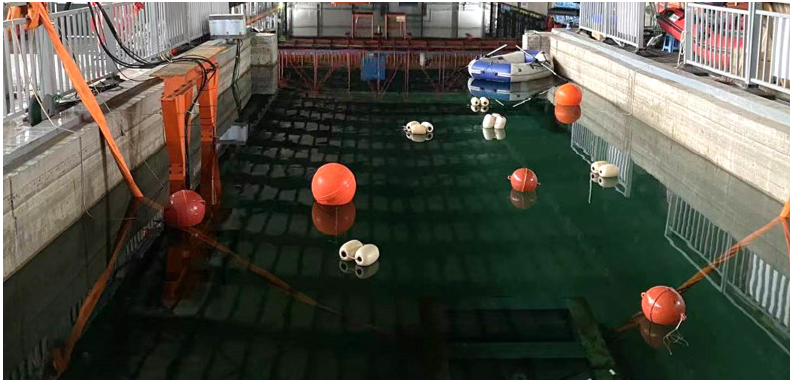
Figure 16. Test map for qualitative analysis. The APF algorithm was selected for the comparative analysis, and the navigation trajectory was drawn as shown in Figures 17 and 18. The black dot represents the starting position of the USV, and the yellow five-pointed star represents the destination.